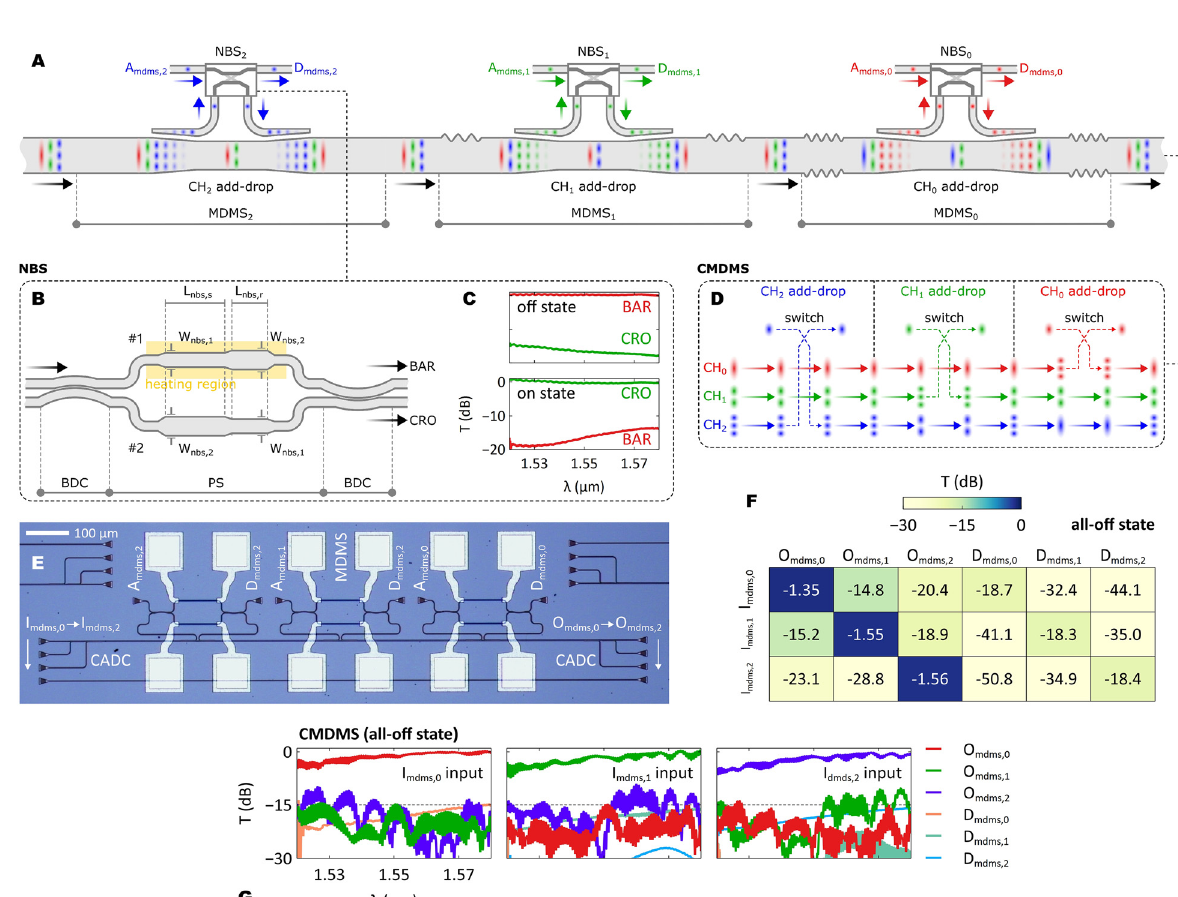
Figure 5: Design and all-off measurement results for direct-access mode-division multiplexing switches (MDMS). (A) The schematic configuration of cascaded MDMSs (CMDMS). (B) The schematic configuration of normally-bar switch (NBS). (C) The measuredtransmittancespectraforNBSatoffstate(upperpanel)andonstate(lowerpanel).(D)Theillustrationofmodeadd-dropoperations. (E) The optical microscope image of fabricated devices with port identifiers labeled. (F) The measured transmittance matrix for CMDMS at all- off state ( λ = 1.55 μ m). (G) The measured transmittance spectra for CMDMS at all-off state as light was launched from input ports. BDC, bent directional coupler; PS, phase shifter; CADC, cascaded asymmetric directional